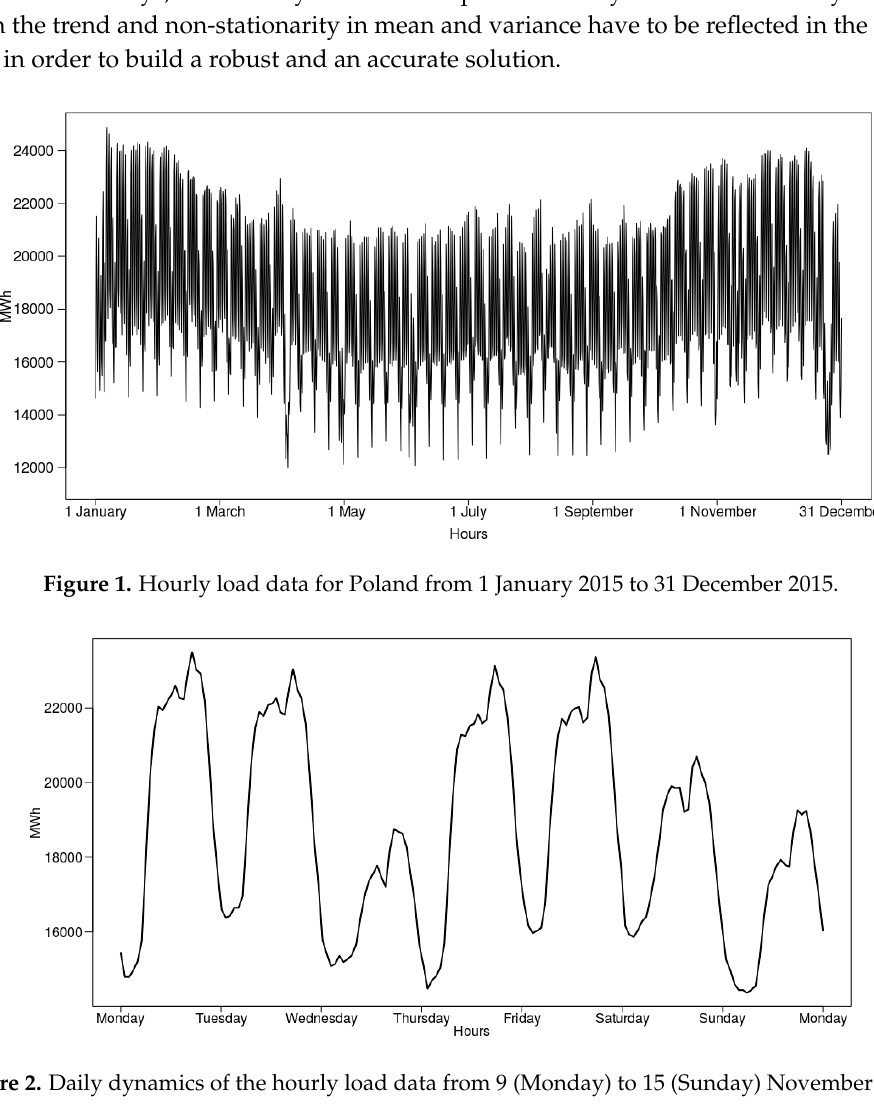
Figure 2. Daily dynamics of the hourly load data from 9 (Monday) to 15 (Sunday) November 2015.